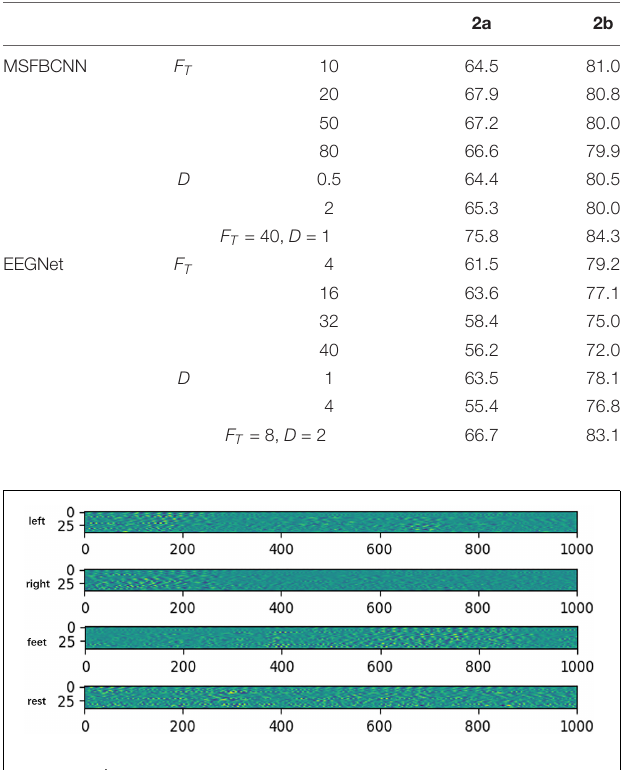
features of left-hand and right-hand tasks are mainly distributed in the 200 ms after the imaging, but they are different in